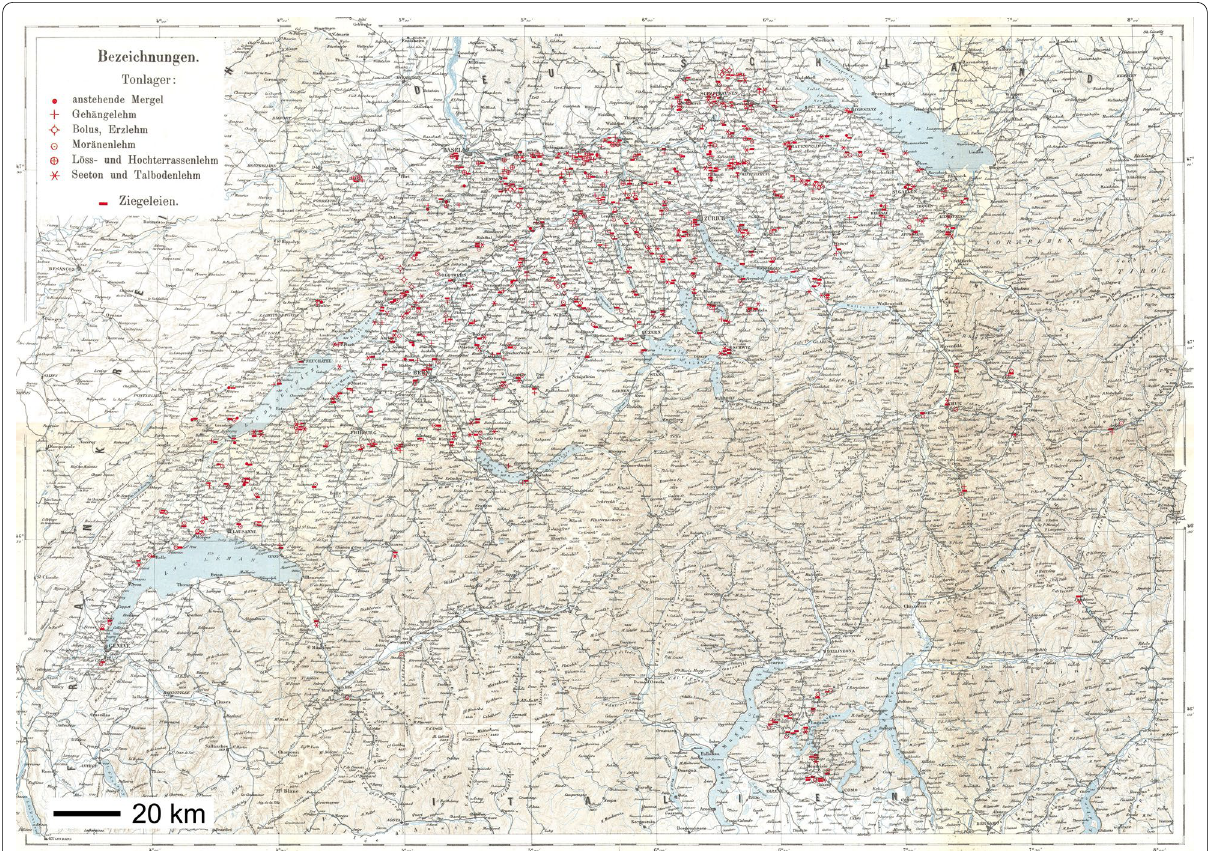
Fig. 6 Clay resources map (1:530 ′ 000) by Letsch et al. (1907). The map is shown in its full extent in order to get an overview of the areas that were explored the most. Details are not readable at that map scale. See the full resolution of this map in Additional file 1. The star-, cross- and circle-like red symbols represent occurrences of different types of clays, marls or brickearth. The fat dashes mark brick factories. Note that most of the occurrences, i.e. mining sites at the beginning of twentieth century were located in the Molasse Basin and in the Jura fold-and-thrust